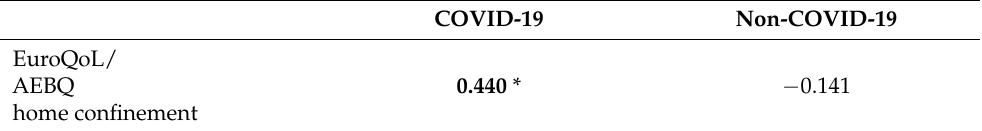
Table 4. Results from multiple regression examining the AEBQ score as predictor of EuroQoL 5D-5L outcomes during